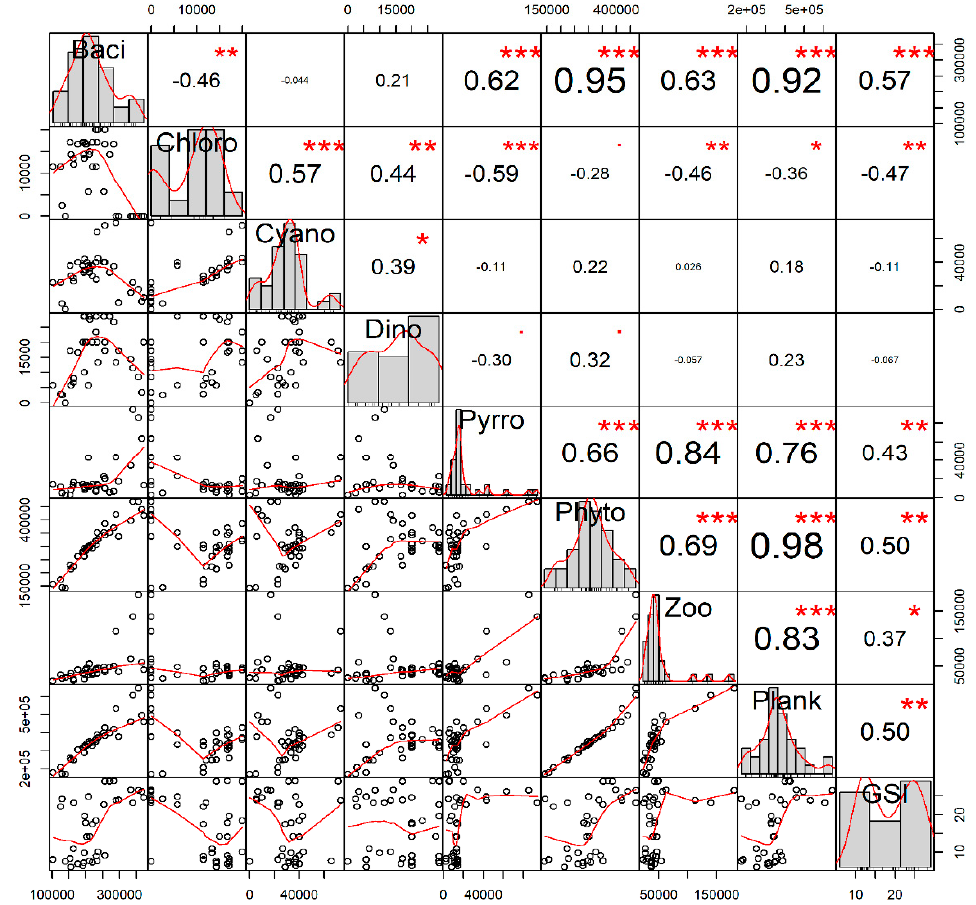
Figure 7. Interrelations among the major groups of the ingested gut plankton (quantity of individuals in whole gut) and the gonadosomatic index (%) of green mussel Perna viridis collected from the coastal waters of Bangladesh during November 2017 to October 2018. The analysis is based on the 20 individuals of green mussel for each month (n = 240). Here, the variables’ full names are: Baci, Bacillariophyceae; Chloro, Chlorophyceae; Cyano, Cyanophyceae; Dino, Dinophyceae; Pyrro, Pyrrophyceae; Phyto, total phytoplankton; Zoo, total zooplankton; Plank, total plankton; and GSI, gonadosomatic index. The values given around all the axes are the range of each individual parameter’s measured values. Correlation coefficients are indicated with numeric values, while significance levels are denoted by asterisks (* < 0.05, ** < 0.01, *** < 0.001).